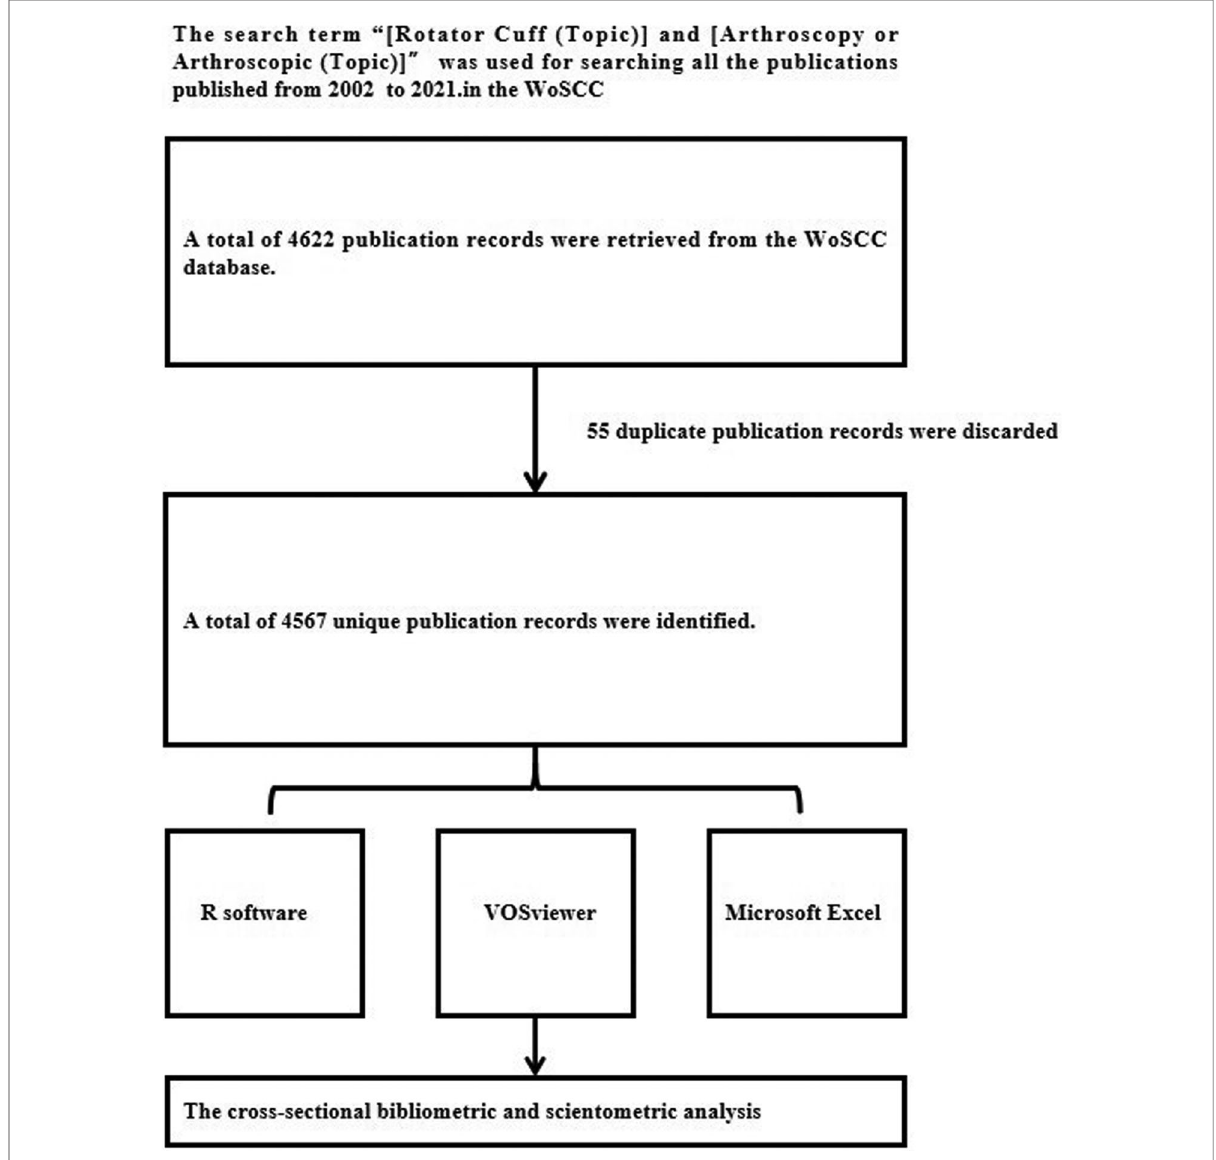
FIGURE 1 The fl ow chart for the “ Search Strategy ” : a total of 4,567 unique publication records were identi fi ed for the cross-sectional bibliometric and scientometric